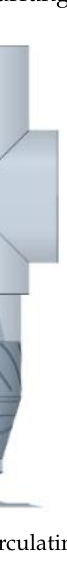
Figure 2. The arrangement of the pump. The water inlet channel structure is shown in Figure 3. The water flow in the cool- ing tower enters the channel diversion from the inlet; the channel diversion consists of two arc-shaped water channels separated symmetrically in the middle. After the water passes through the open forebay, the water flow enters the A, B, and C water suction chambers separated by unit, then the circulating pump in the water suction chambers pumps water into the drainage pipeline. The operating water level of the water suction chamber is 8 m ; one pump has a flow rate of 9.59 3 m / s and is ahead of 28.65 m . The summer operation condition is adopted in the simulation. That is, three pumps run sim- ultaneously.